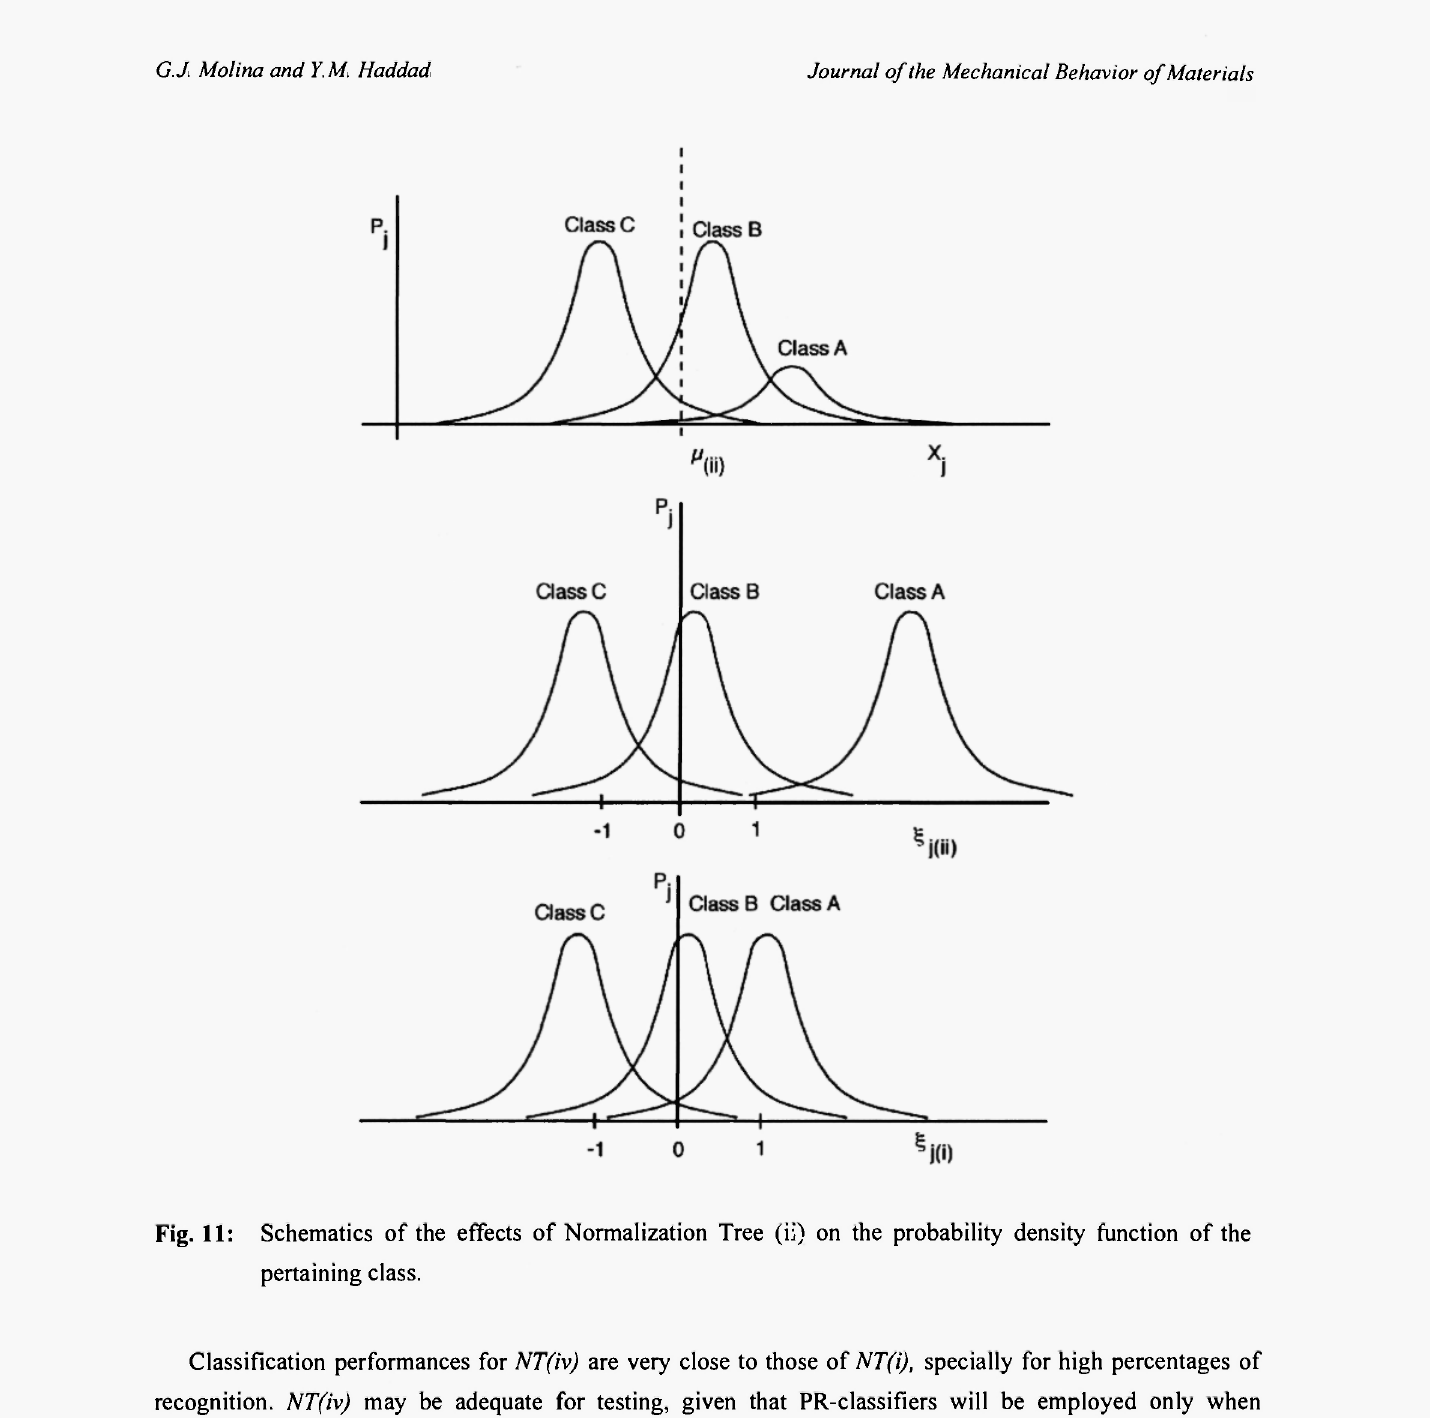
Fig. 11: Schematics of the effects of Normalization Tree (ii) on the probability density function of the pertaining